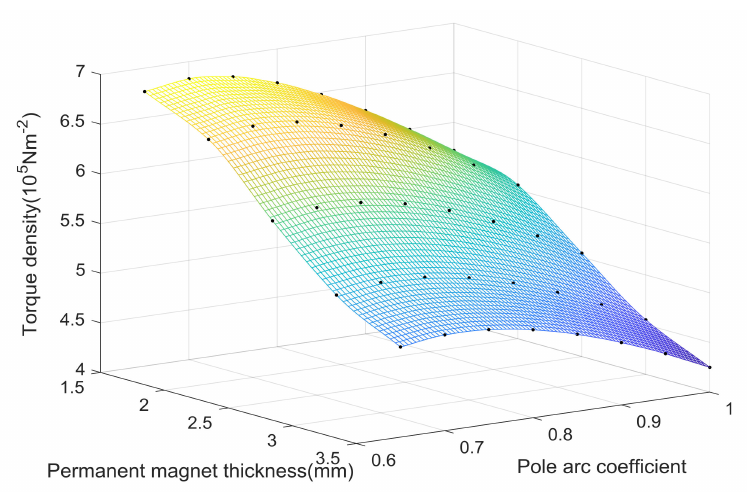
Figure 22. Response surface of sub objective function S T .